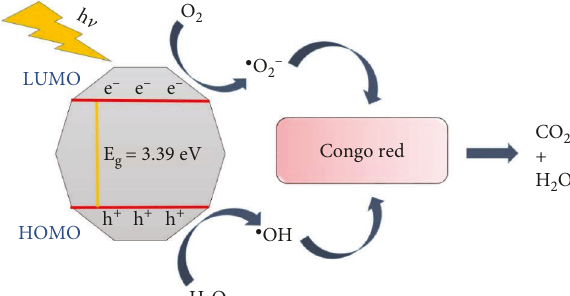
Figure 10: The plausible mechanism of the photodegradation of Congo red under UV light irradiation using complex 2.